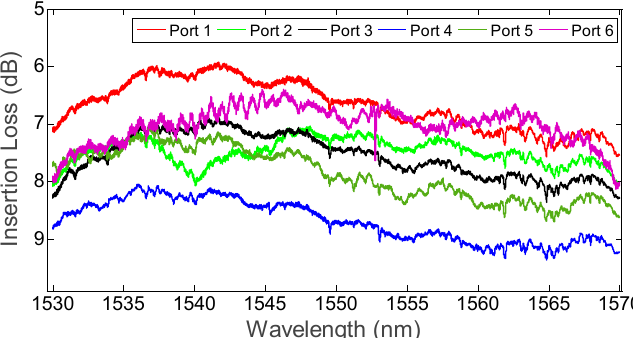
Figure 5. Measured total insertion loss (IL) for six ports in the full C-band wavelengths.